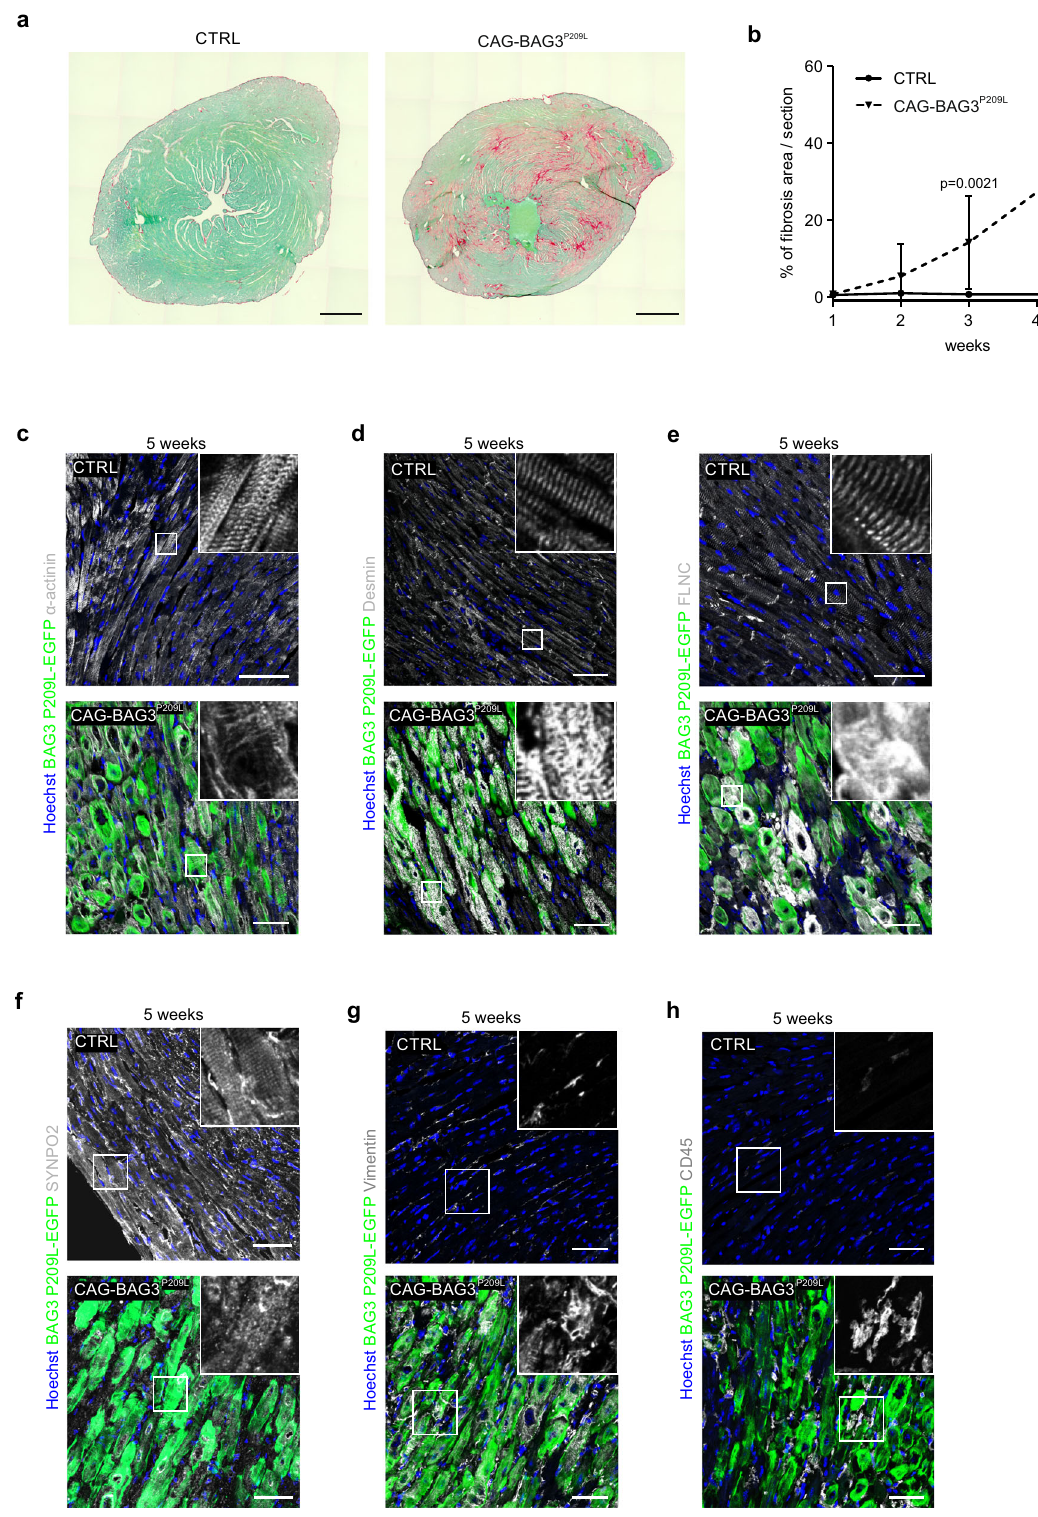
Fig. 3 Cardiac fi brosis and formation of aggregates in CMs from CAG-BAG3 P209L mice. a Analysis of cardiac fi brosis by Sirius red and fast green stainings: red collagen staining indicates massive fi brosis in hearts from CAG-BAG3 P209L mice. b Quanti fi cation of the fi brotic area in CAG-BAG3 P209L mice and CTRL. Mean ±SD. N (1 week) = 3 CTRL and 3 CAG-BAG3 P209L mice; n (2 weeks) = 3 CTRL and 6 CAG-BAG3 P209L mice; n (3 weeks) = 10 CTRL and 13 CAG-BAG3 P209L mice; n (5 weeks) = 4 CTRL and 6 CAG-BAG3 P209L mice. One-way ANOVA. c – h Sections of hearts from 5-week-old CAG-BAG3 P209L and CTRL mice were stained for α -actinin ( c ), desmin ( d ), FLNC ( e ), SYNPO2 ( f ), vimentin ( g ), and CD45 ( h ). In BAG3 P209L -eGFP (green) CMs the formation of large aggregates was observed. Scale bars: 50 μ m. c – h The experiments were repeated three times from three independent biological replicates with similar results. CTRL, control mice (siblings of CAG-BAG3 P209L mice, which are either WT, PGK-Cre, or CAG- fl ox-hBAG3 P209L